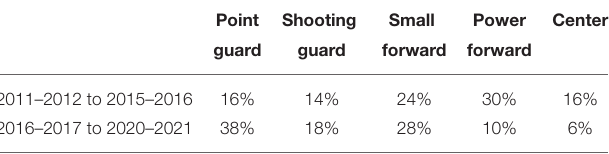
TABLE 1 | The percentage of top 10 compensated nba players across the five positionsm. Point Shooting Small